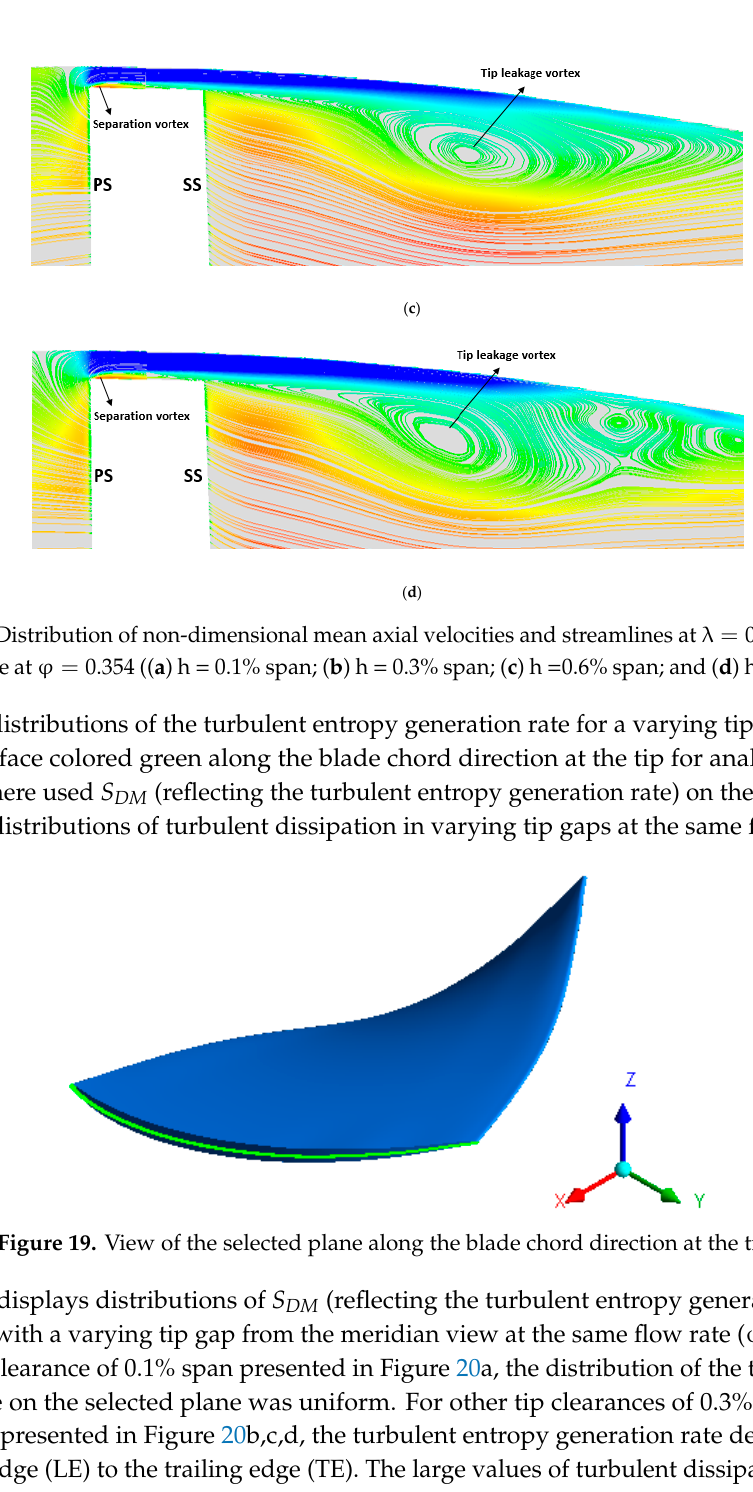
Figure 19. View of the selected plane along the blade chord direction at the tip.